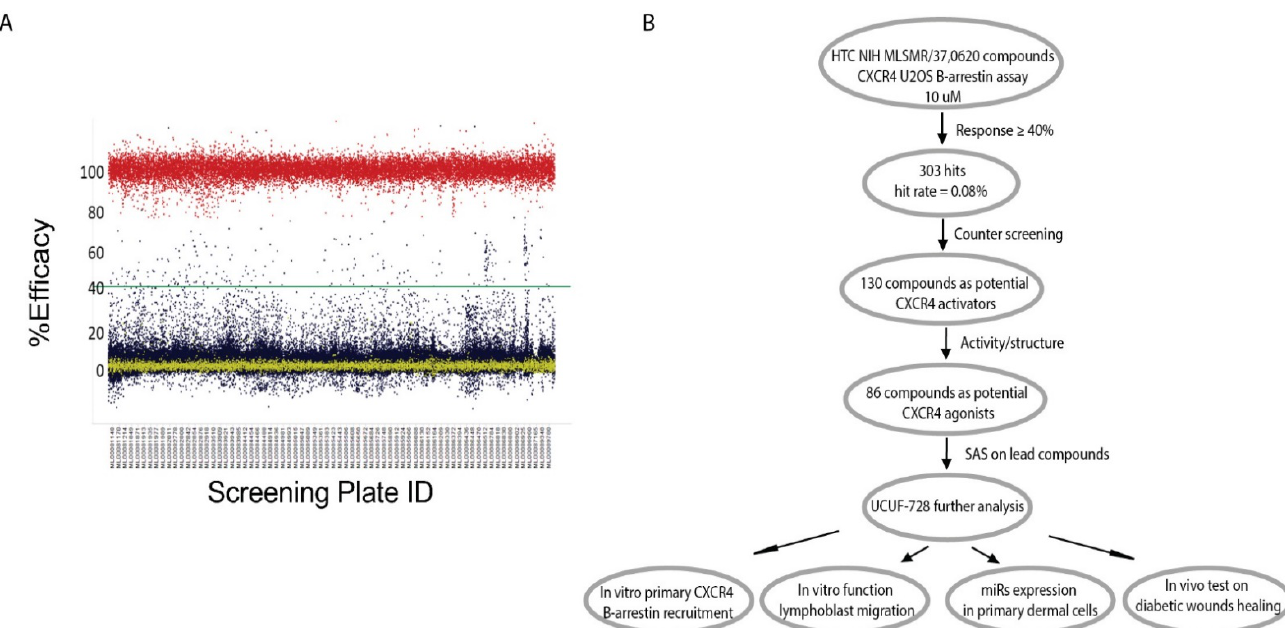
Figure 1. High-Throughput Screening for CXCR4 Activators. ( A ) Scatter plot of test compounds at 10 mM (blue). For positive (high) control (red dots), 100 nM SDF-1 α was used, and DMSO was used as negative (low) control (yellow dots). DMSO in all wells was <0.5%. Z ′ = 0.83. ( B ) Assay cascade for identification of lead CXCR4 activator and the workflow of this study.